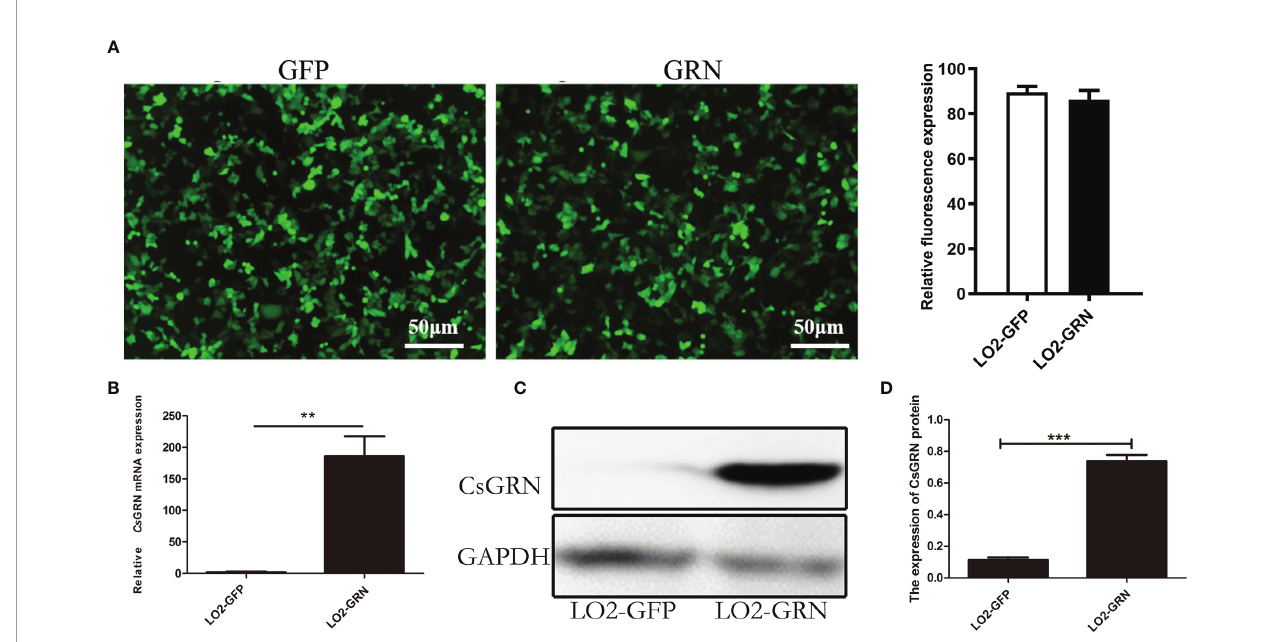
FIGURE 1 | Stable expression of pEGFP-C1- Cs GRN in human LO2 hepatocytes. LO2 hepatocytes were stably transfected with pEGFP-C1 or pEGFP-C1- Cs GRN and selected with G418-containing medium. Cell lines were named as LO2-GFP and LO2-GRN, respectively. (A) Green fl uorescence was observed by inverted microscope to determine the ef fi ciency of transfection (scale bar is 50 µm), and the quanti fi cation of green fl uorescence was measured by Image J software. (B) Relative mRNA levels of Cs GRN were quanti fi ed by q-PCR. (C) The expression of Cs GRN protein were determined by Western blotting. (D) Relative protein levels of Cs GRN were quanti fi ed by Image J software from three independent experiments. ** P < 0.01 versus control group, *** P < 0.001 versus control